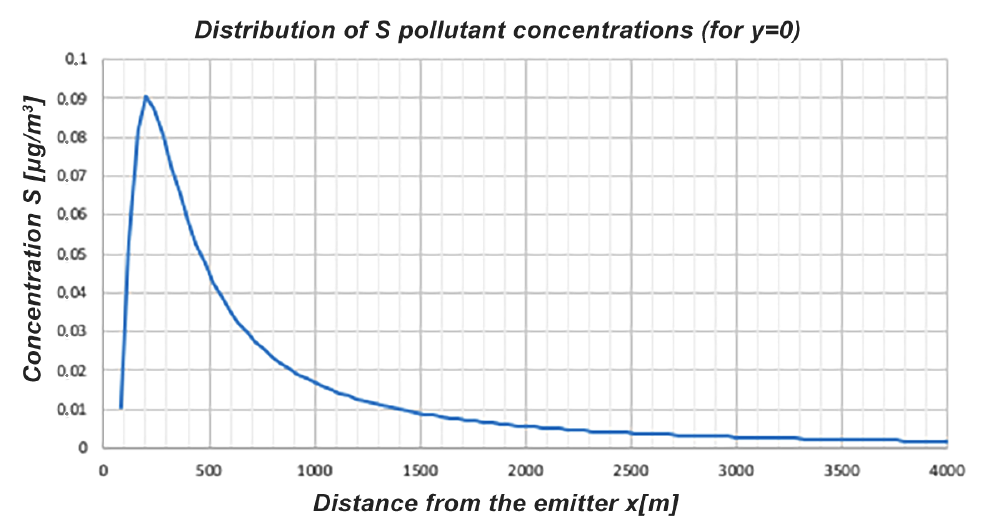
Figure 4. Dependence of the distribution of the emitted S pollutant concentrations at distance x from the